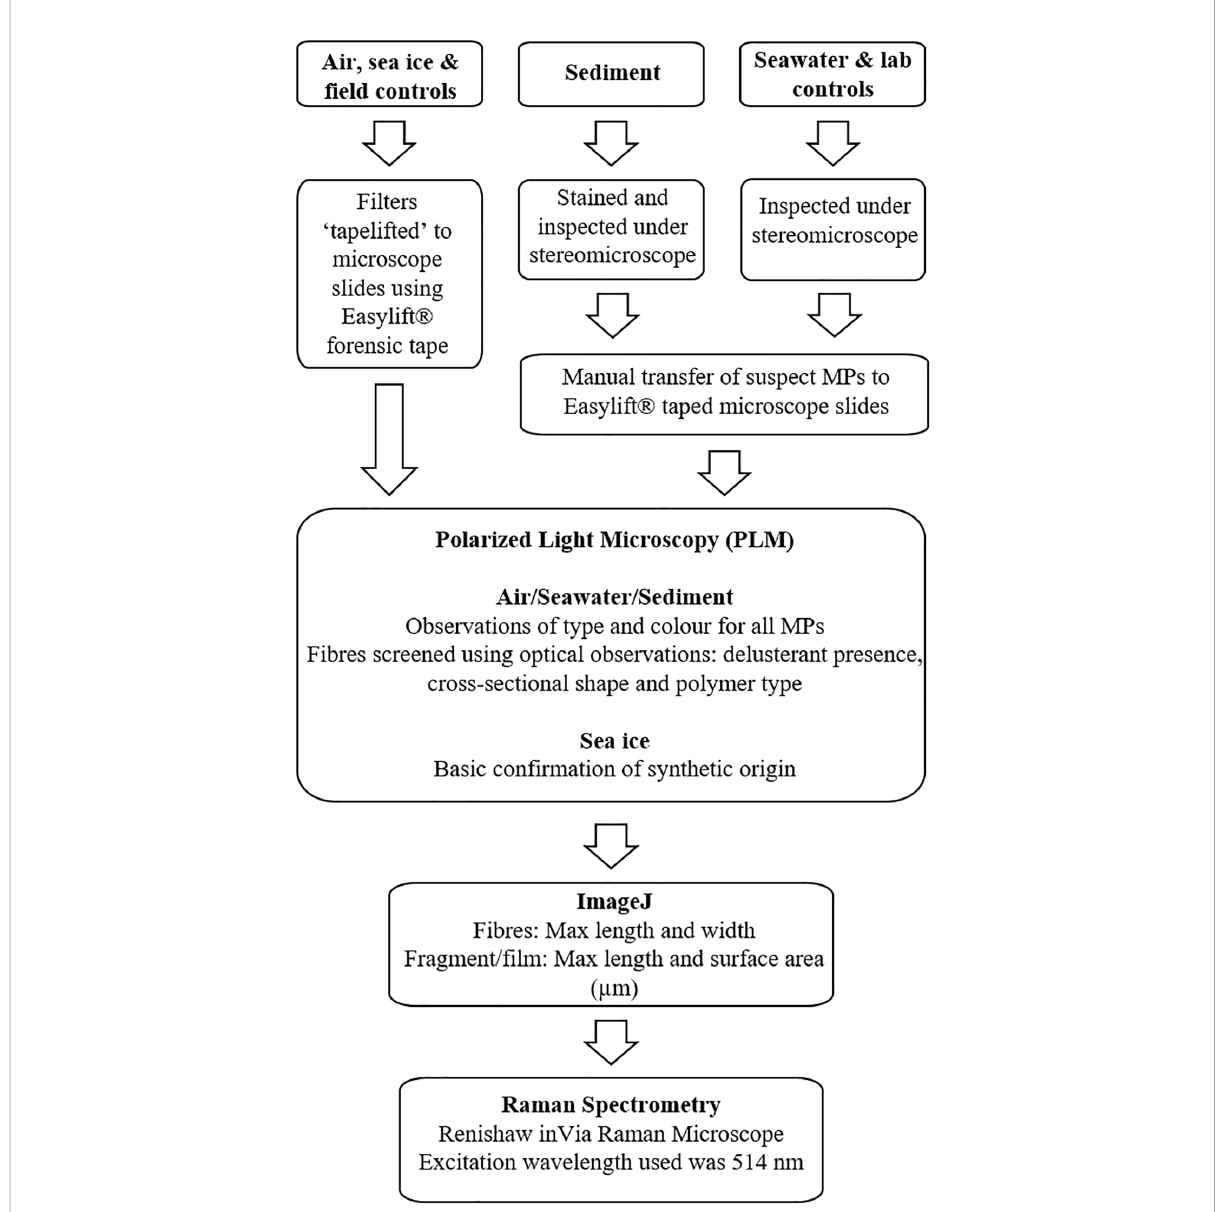
FIGURE 2 A work fl ow diagram illustrating the extraction of prospective microplastics from each sample medium and the subsequent optical observations and chemical identi fi cation